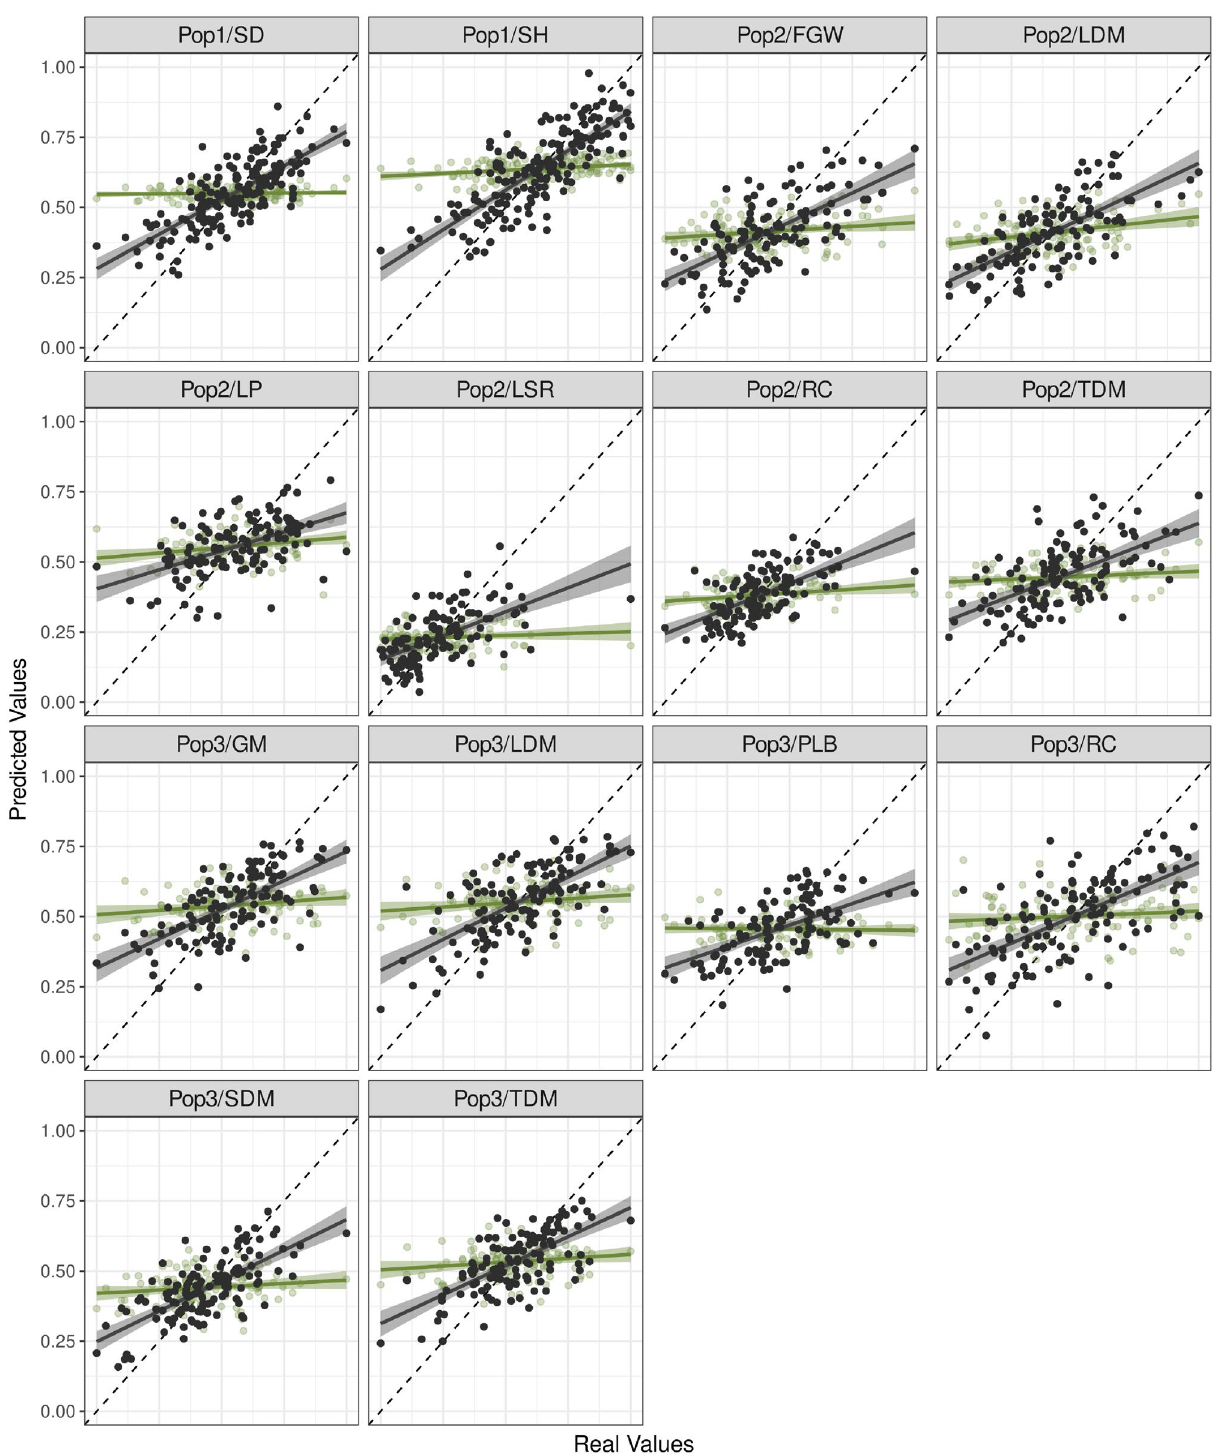
Figure 3. Correlation plots for the predicted and real values in the populations: (Pop1) sugarcane (stalk diameter (SD) and stalk height (SH)); (Pop2) Urochloa decumbens (field green weight (FGW), leaf dry matter (LDM), leaf percentage (LP), leaf stem ratio (LSR), regrowth capacity (RC), and total dry matter (TDM)); and (Pop3) Megathyrsus maximus (green matter (GM), LDM, percentage of leaf blade (PLB), RC, stem dry matter (SDM), and TDM). The approaches evaluated were Bayesian ridge regression (BRR), colored green, and the single-environment main genotypic effect model with a Gaussian kernel (SM-GK) with the inclusion of the established feature selection machinery, colored